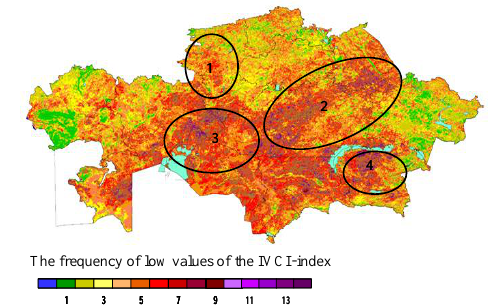
Figure 8. The schematic map of frequency of droughts (IVCI values smaller 30%) during